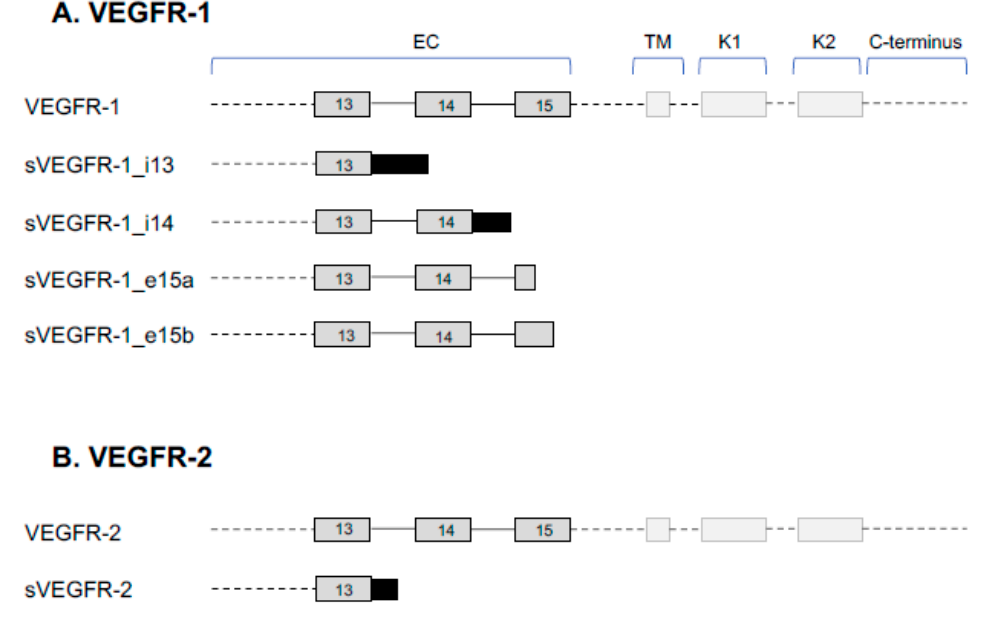
Figure 1. Alternative splice variants of VEGFR-1 and VEGFR-2. ( A ) Alternative splicing gives rise to five known splice variants of VEGFR-1: full length VEGFR-1, intron 13 retention (sVEGFR-1_i13), intron 14 retention (sVEGFR-1_i14), terminal exon 15a (sVEGFR-1_e15a), and terminal exon 15b (sVEGFR-1_e15b). The soluble isoforms only contain the extracellular (EC) domain and are missing the transmembrane (TM) and kinase (K1 and K2) domains. ( B ) Alternative splicing gives rise to two known splice variants of VEGFR-2: full length VEGFR-2 and sVEGFR-2, which result from intron 13 retention. The sVEGFR-2 only contains the EC domain.